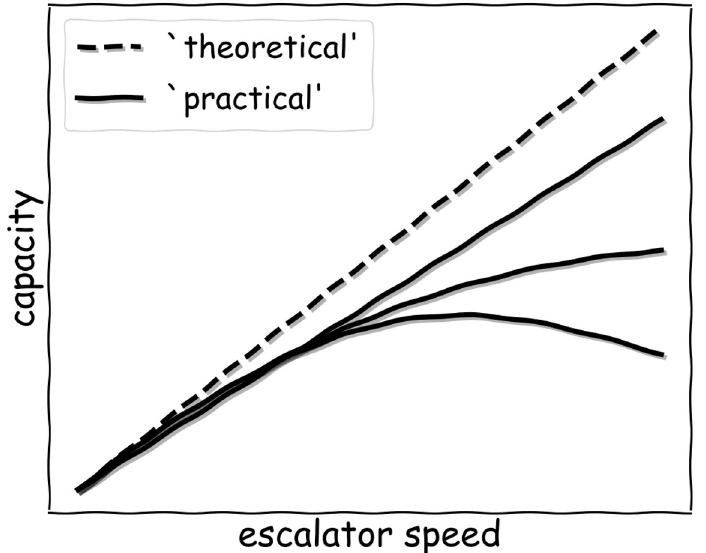
Fig 1. Qualitative difference between the ‘theoretical’ and the ‘practical’ escalator capacity in the range of typical conveyor speeds. Regarding the ‘practical’ capacity, linear, saturating, and even decreasing curve progressions can be found in the